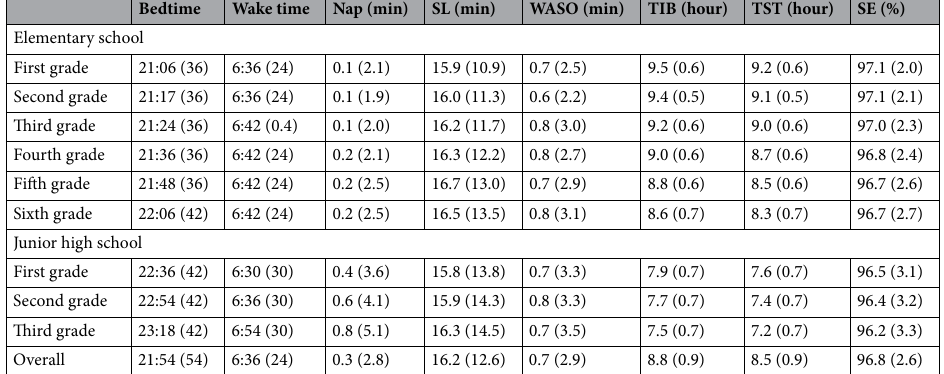
Table 1. Sleep habits by school grade. Continuous variables are expressed as the mean ± standard deviation. SE sleep efficiency, SL sleep onset latency, TIB time in bed, TST total sleep time, WASO wake after sleep